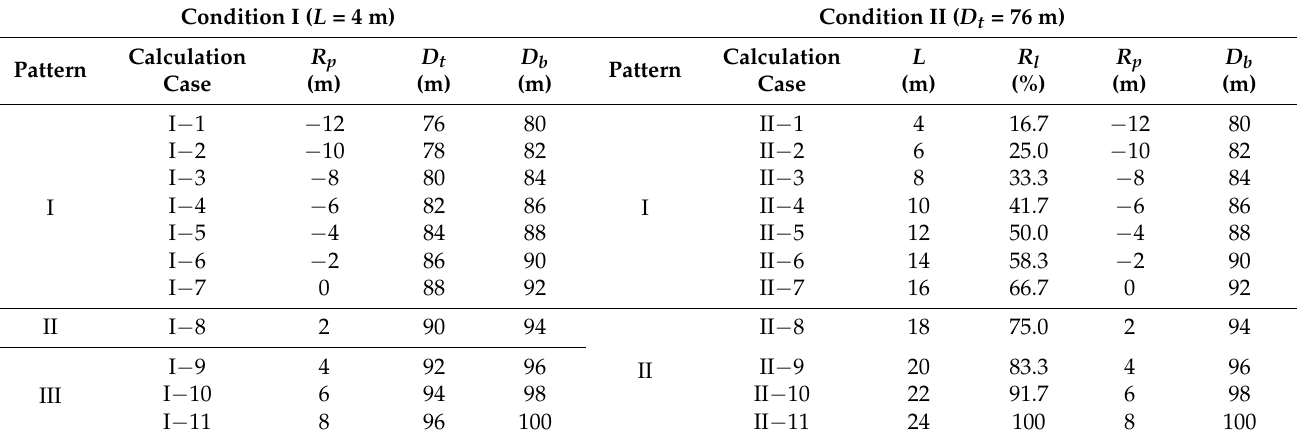
Table 3. Simulated cases considering different R p and L values.